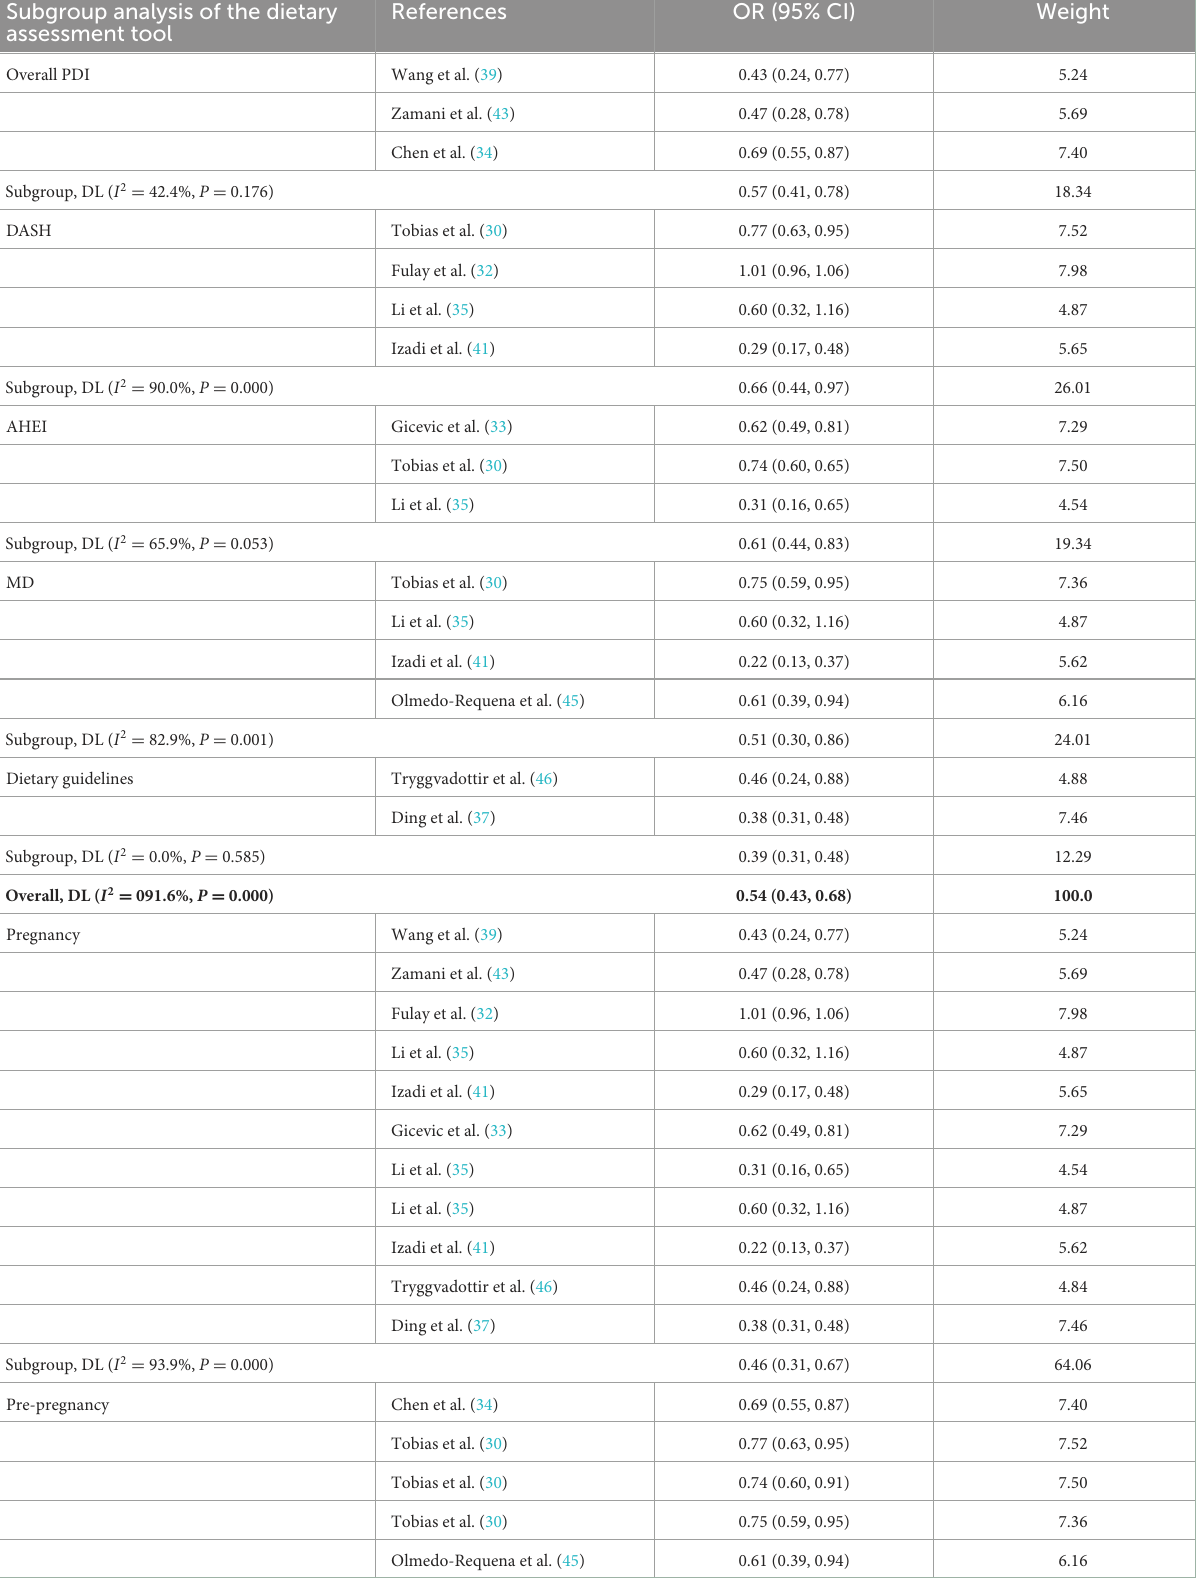
TABLE 3 Subgroup analysis of the Group A (including dietary assessment tools, participants, country, study quality, and study design). Subgroup analysis of the dietary assessment